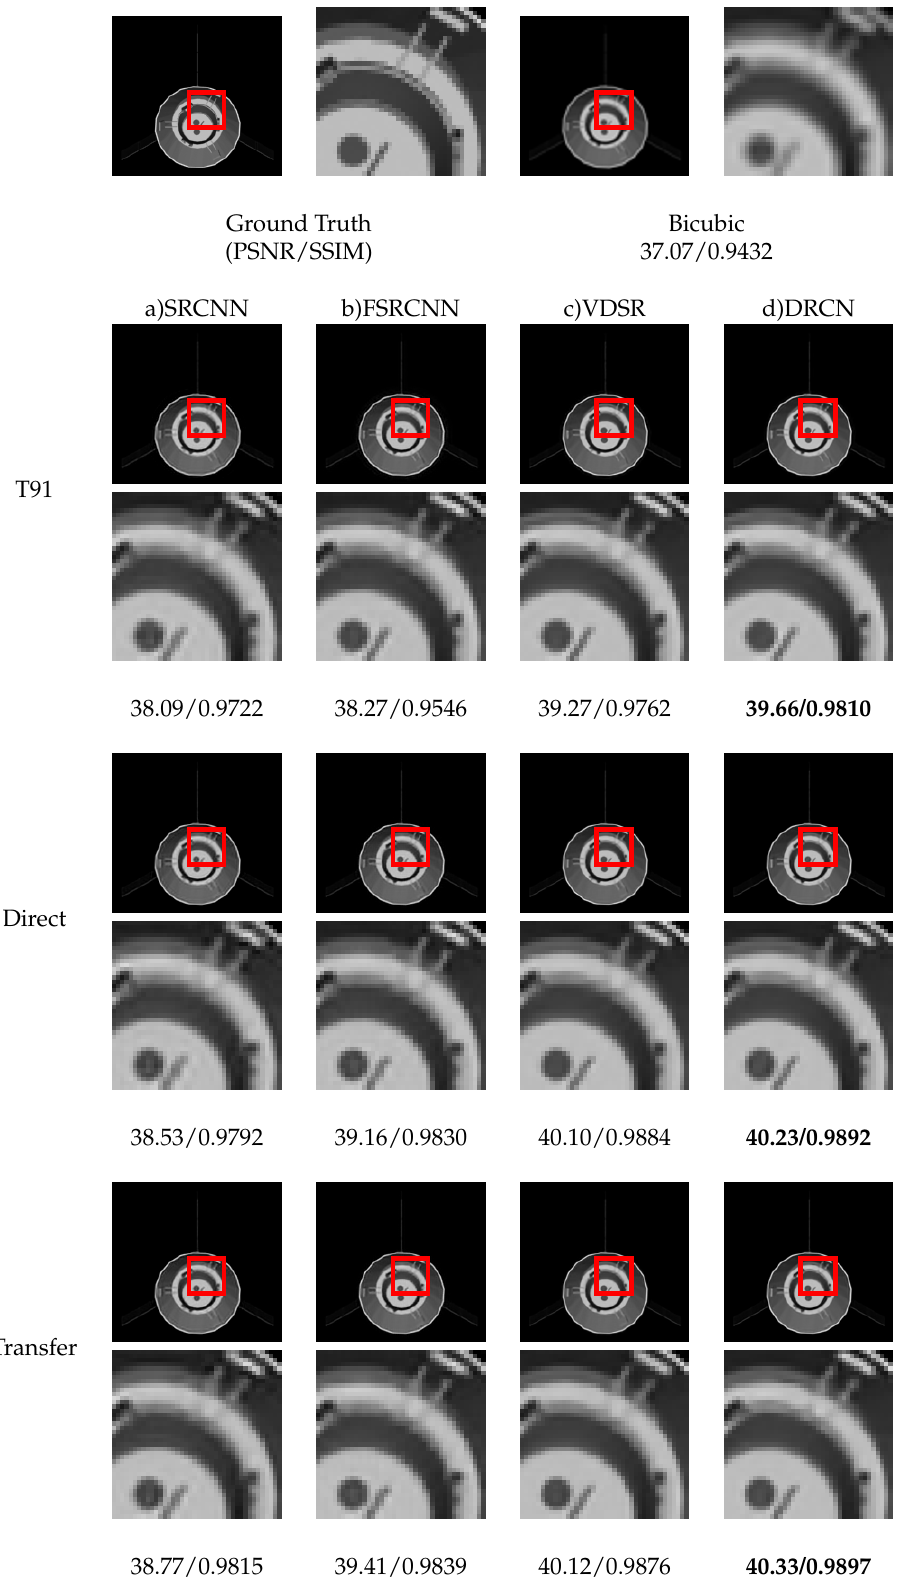
2. Models are trained ×